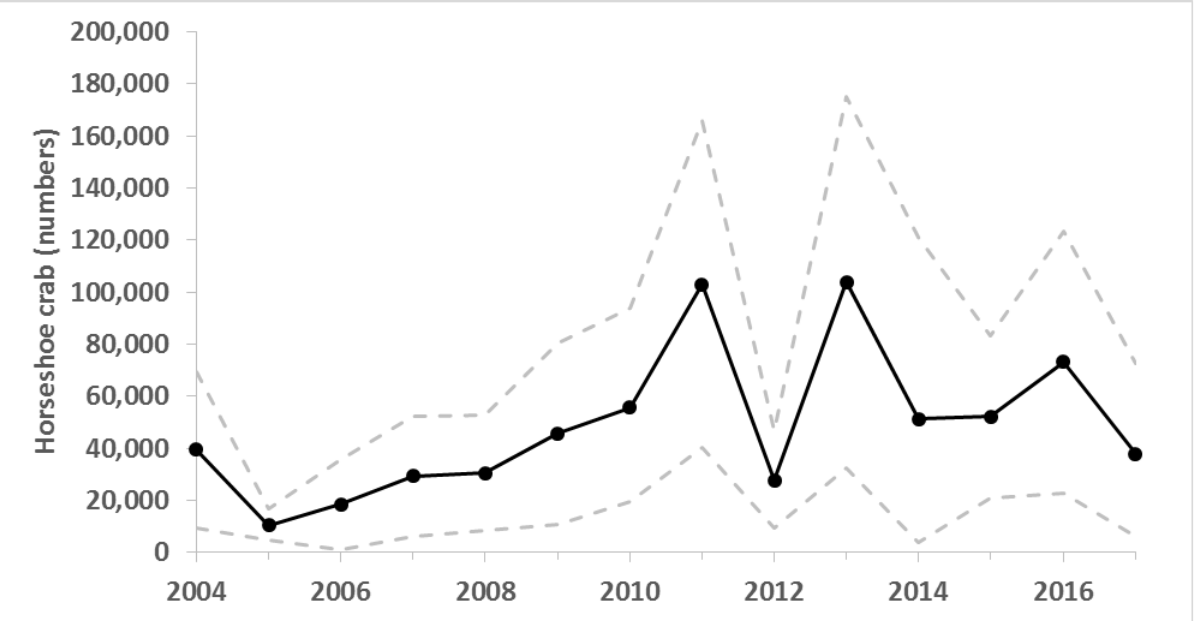
Figure 21. Number of dead discarded female horseshoe crabs in the Delaware Bay region, 2004-2017, from gillnets, trawls, and dredges with 95% confidence